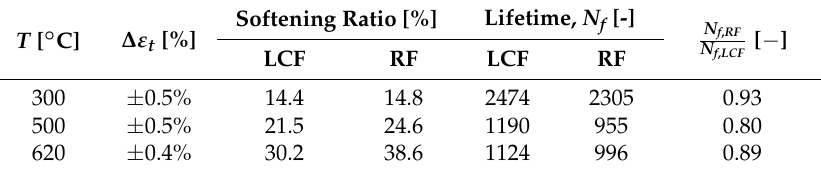
Figure 12. Cyclic stress response curves ( a ) and hysteresis loops at half-lifetime ( b ) of different LCF- and RF-tests. Table 7. Softening ratio, lifetime, and lifetime ratio for the different LCF- and RF-tests.